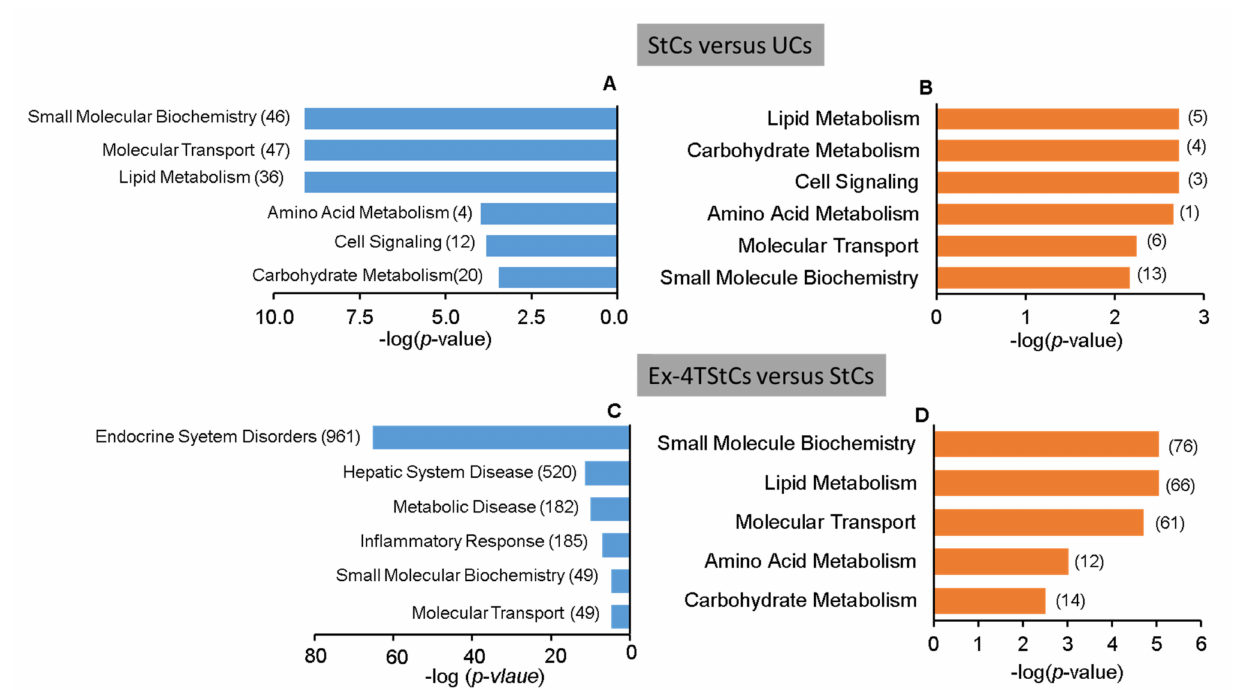
Figure 3. Molecular and cellular functions related to NAFLD ( A , B ) Molecular and cellular functions potentially related to NAFLD identified with the down- ( A ) and up- ( B ) regulated DEGs between StCs and UCs datasets. ( C , D ) Molecular and cellular functions potentially related to NAFLD identified with the down- ( C ) and up- ( D ) regulated DEGs between StCs and Ex-4-TStCs datasets. The numbers between parentheses indicate the number of genes involved in each